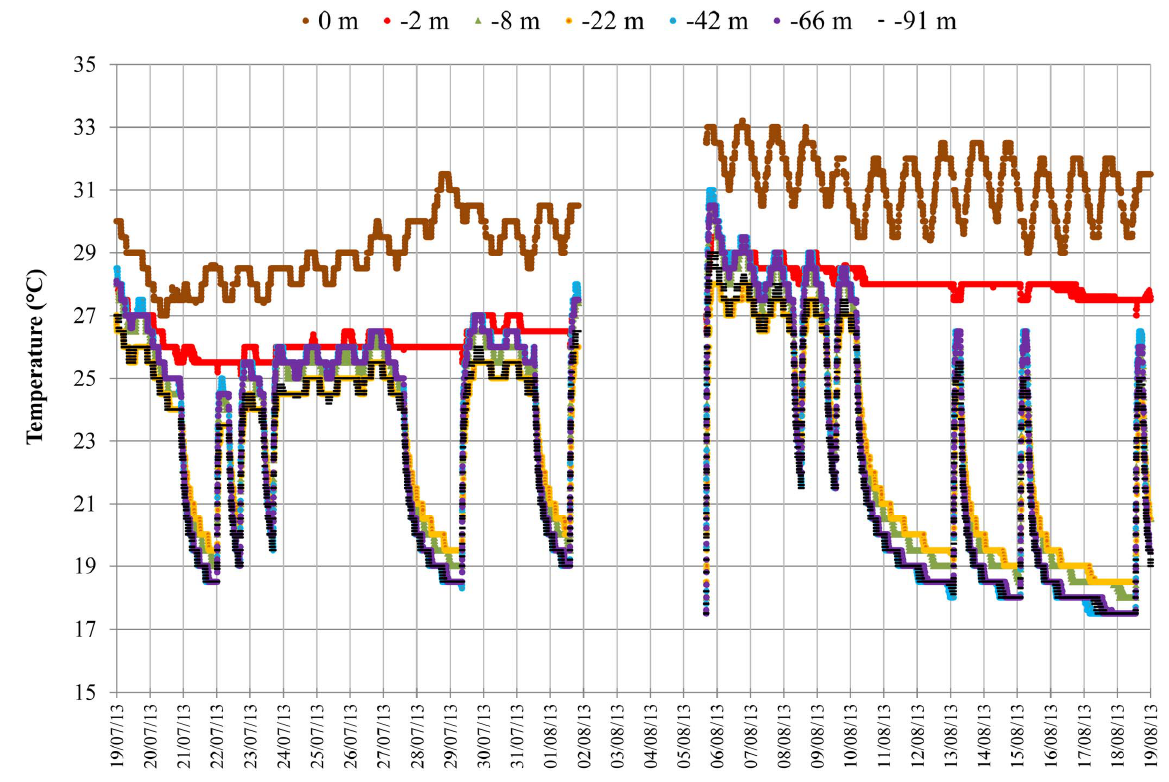
Figure 7. Temperature profile along the geothermal borehole. A power outage affected the monitoring system (from 2 August to 5